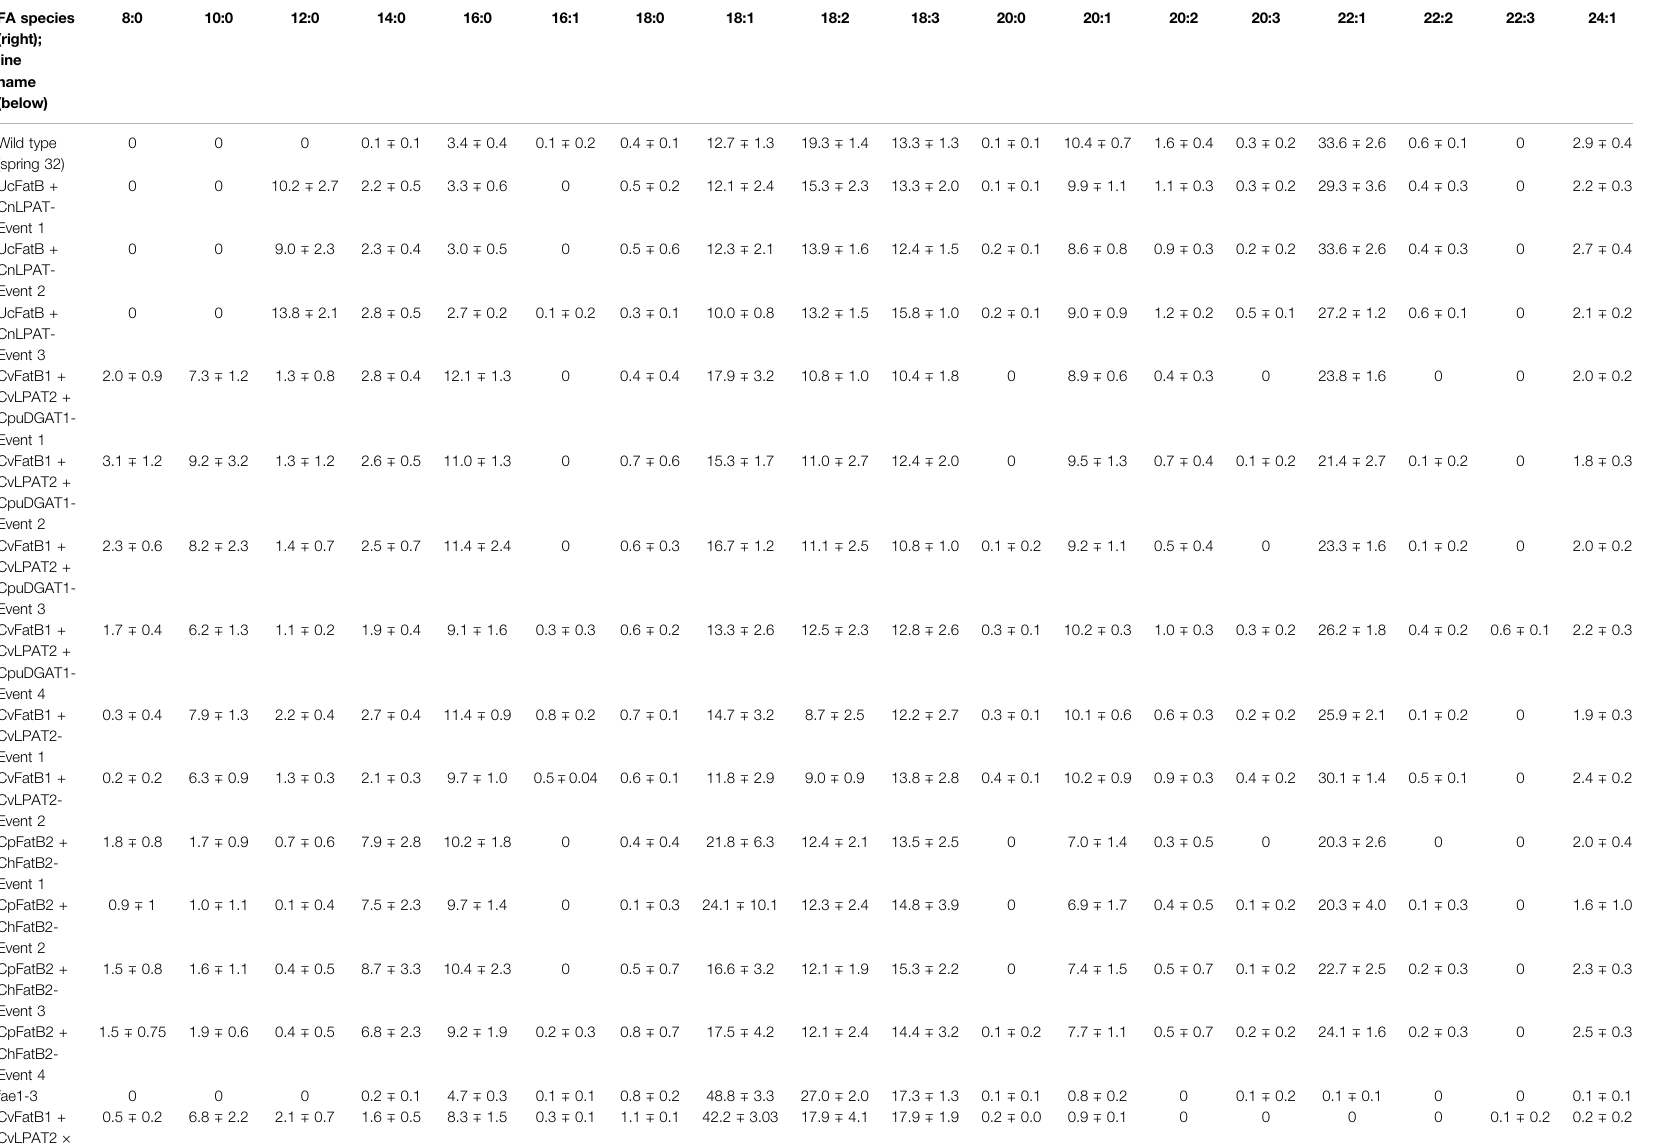
TABLE 1| Amounts of fatty acid (FA) species in TAGs or acetyl-TAGs ofpennycress MCFA biosynthetic genes-containing transgenic lines as well as stacks of those lines with an fae1-3 knockout mutation or seed-speci fi c- expressed EaDAcT transgene. FA species